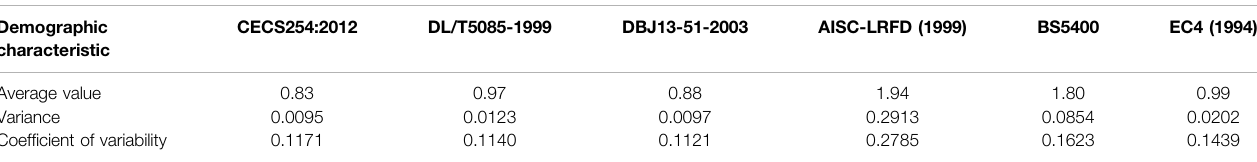
TABLE 10 | N t u / N c u demographic characteristics of